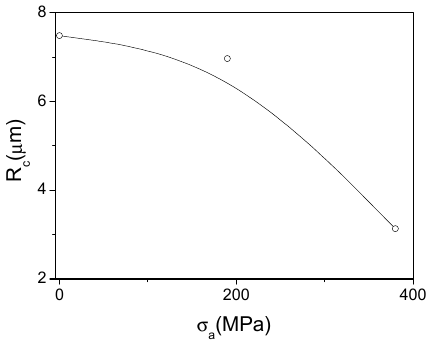
Figure 17. Effect of the stress applied during the annealing at T ann = 300 °C on R c values of Fe 75 B 9 Si 12 C 4 Figure 17. E ff ect of the stress applied during the annealing at T ann = 300 ◦ C on R c values of Fe 75 B 9 Si 12 C 4 microwire. The line is for the eyes only. microwire. The line is for the eyes only.